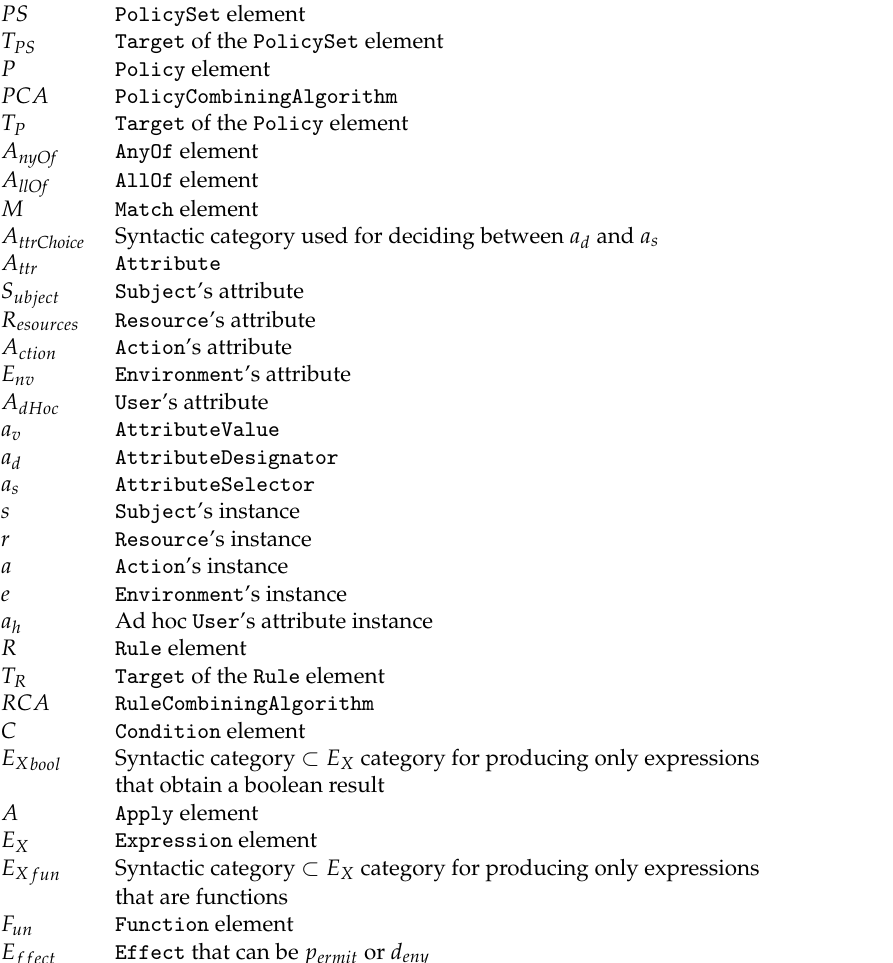
Table 2. Symbols of the grammar.